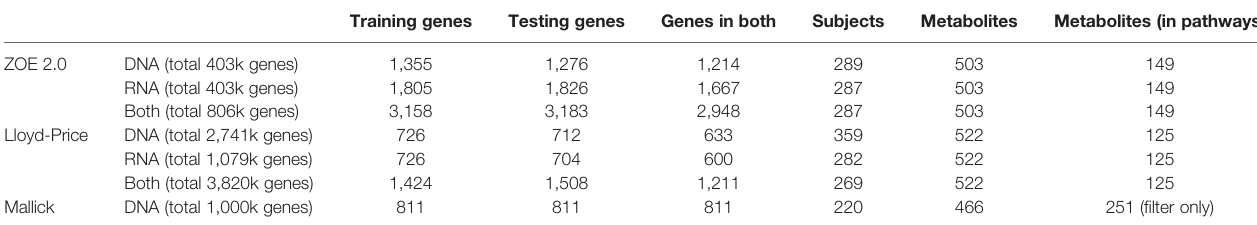
TABLE 1 | Sample size and number of selected gene family features.